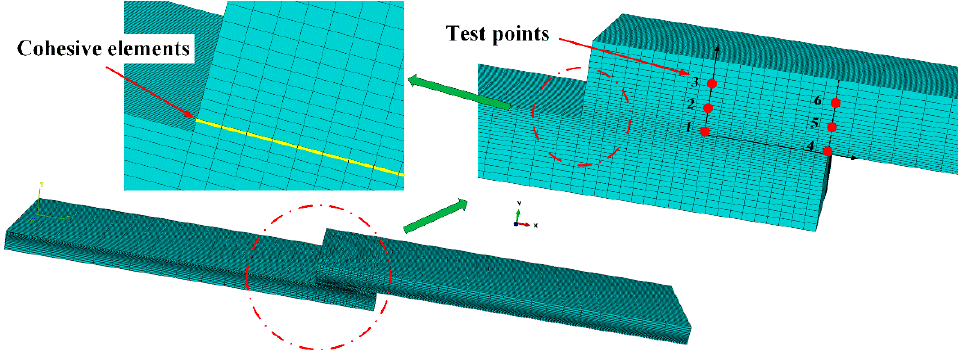
L L = 10 mm adhesively = 10 mm adhesively